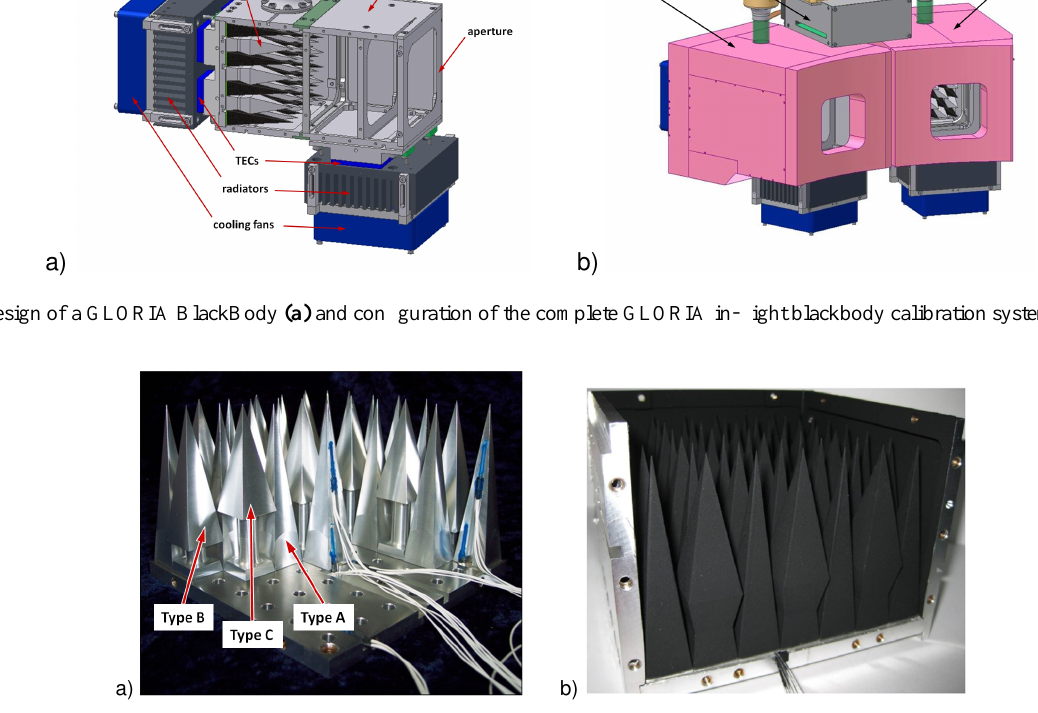
Fig. 4. Design of the optical surface: array of 49 individual pyramids (a) varnished with NEXTEL-Velvet Coating (b) .